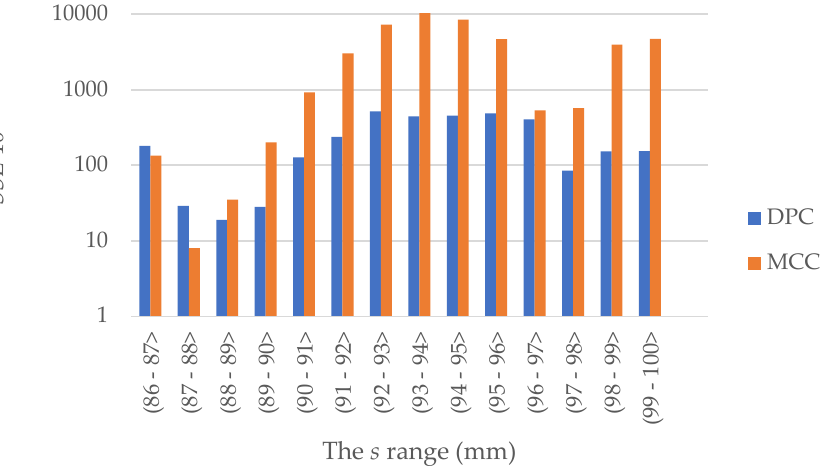
Figure 7. The change in the SSE value, in 1 mm intervals.